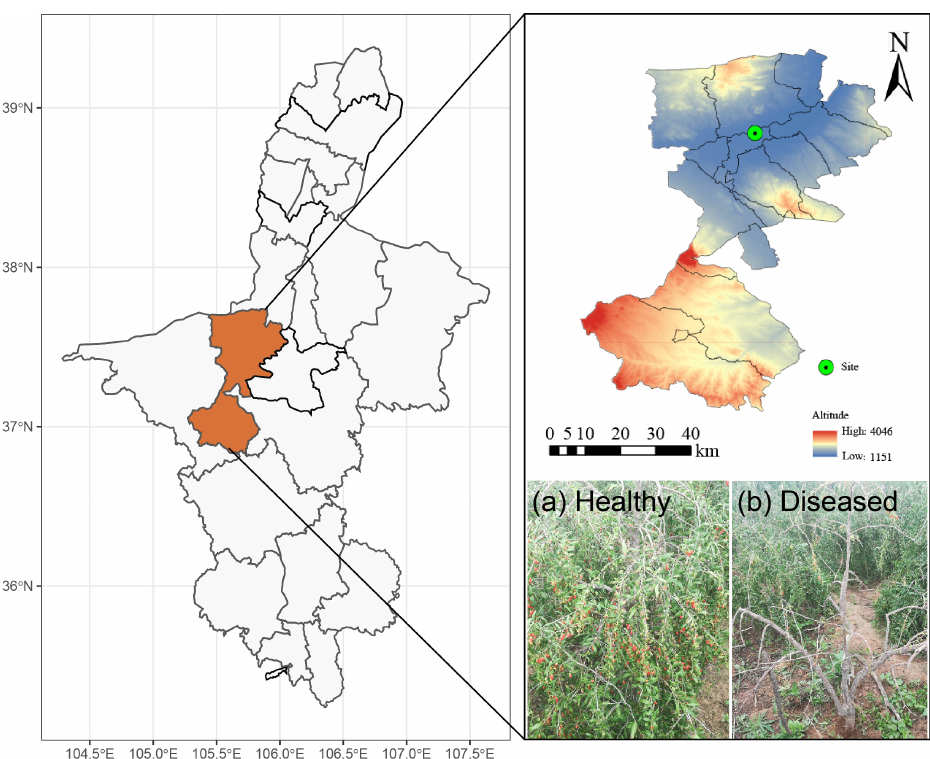
Figure 1 . Diagram of the sampling site. Note: The upper figure shows the sampling site, and the lower-right part of the figure shows a healthy Chinese wolfberry plant and a Chinese wolfberry plant with root rot